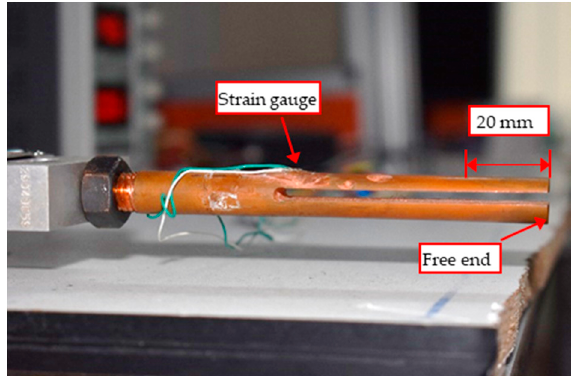
Figure 3. Pinch force load cell.